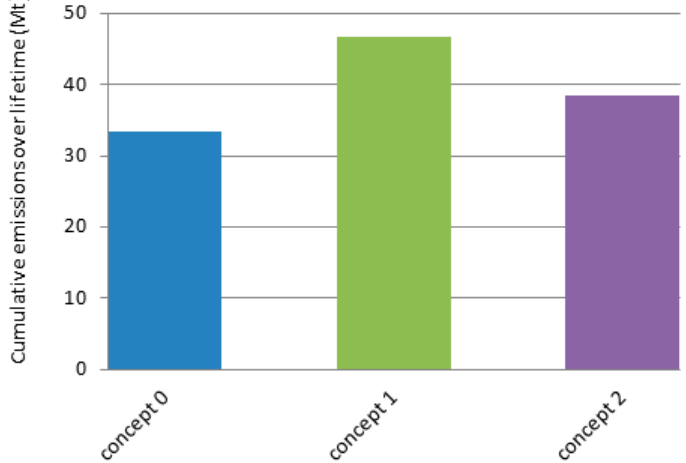
Figure 12. Cumulative CO 2 emissions over the lifetime with the marginal method from the selected concepts.